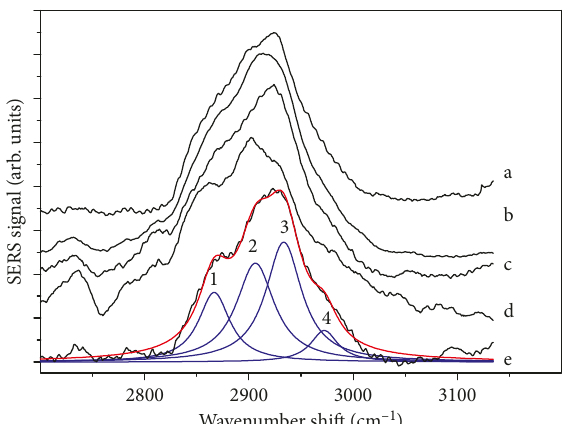
Figure 6: Representative SERS spectra from noncommercial EVOO samples from different sites (a) Triggiano, (b) Avella, (c) Chiaromonte, 1 region due to lipid contribution. The results of deconvolution procedure are also (d) Bellona, and (e) Alberobello in 2700–3100cm reported. −